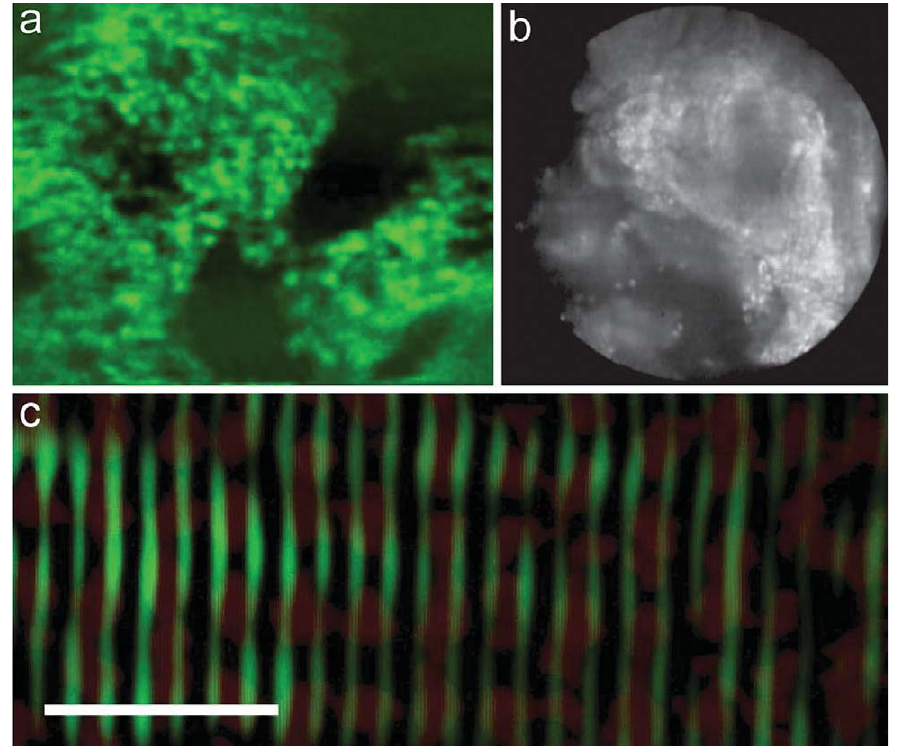
Fig. 4. a: In vivo image of GFP-expressing medulloblastoma in a mouse taken by a miniature dual-axis confocal microscope designed to guide brain tumor resection (image depth is 30 (cid:1) m). The design features a biaxial scanning MEMS mirror and a 2-mm diameter GRIN relay lens [46]. b: In vivo images depicting epithelial cells that have an abnormal appearance, diagnosed as serous cystadenoma. FOV is 450 microns. This image was taken with a confocal microscope designed into a laparoscopic device [117]. c: Image of a cultured mouse muscle fiber with two-photon autofluorescence (red) and second-harmonic generation (green) from sarcomeres. A GRIN relay lens was used to access subsurface muscle. Scale bar indicates 10 (cid:1) m